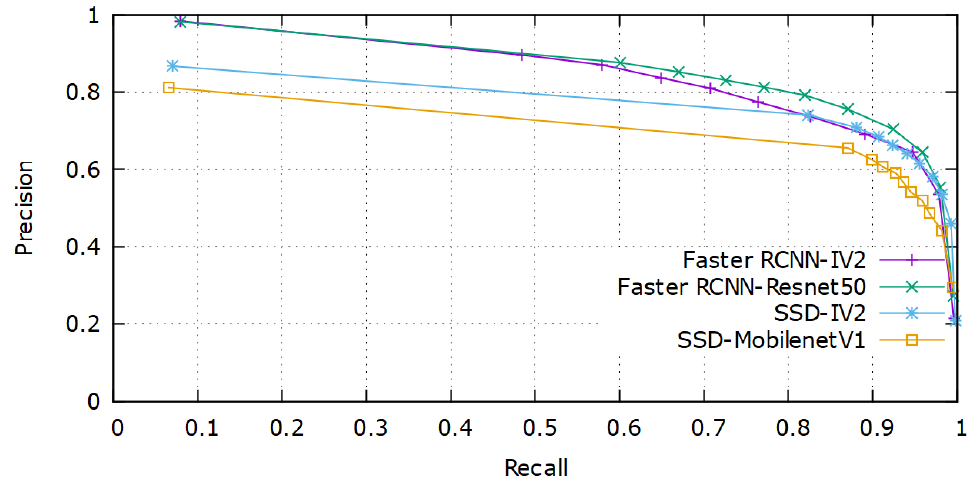
Figure 6. Precision–recall curve comparison of various models for validation set. Note: Faster RCNN-IV2 stands for Faster R-CNN with Inception V2, SSD-IV2 stands for SSD with Inception-V2.